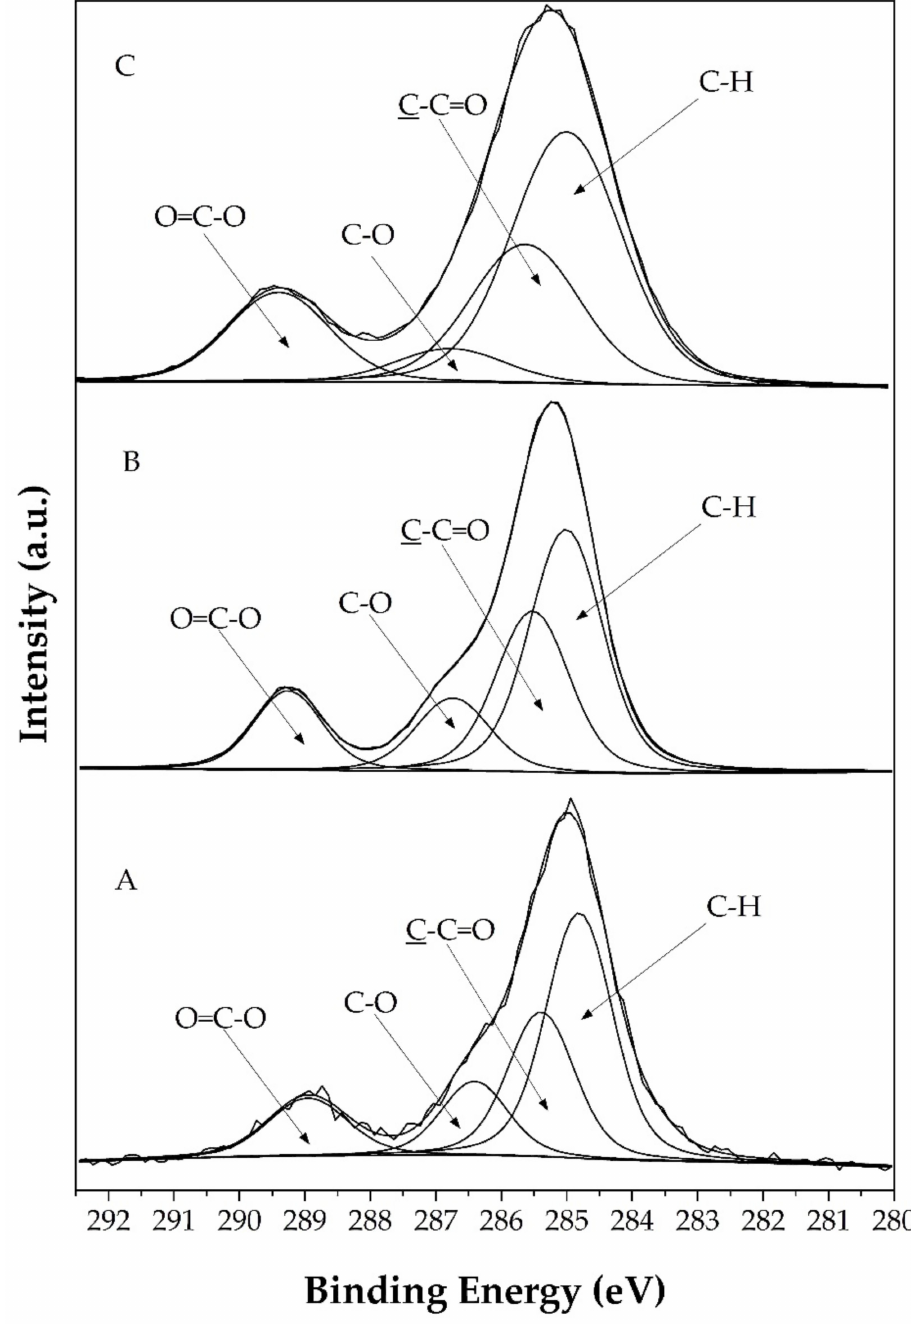
Figure 5. The C1s core level spectra of Mat 2 ( A ), Nano 8 ( B ), and Nano 6 ( C